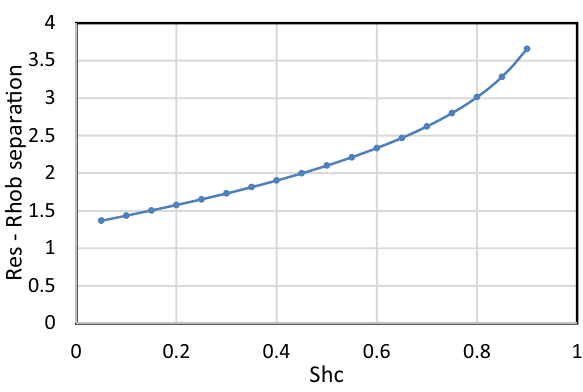
Fig. 14 S hc versus separation for